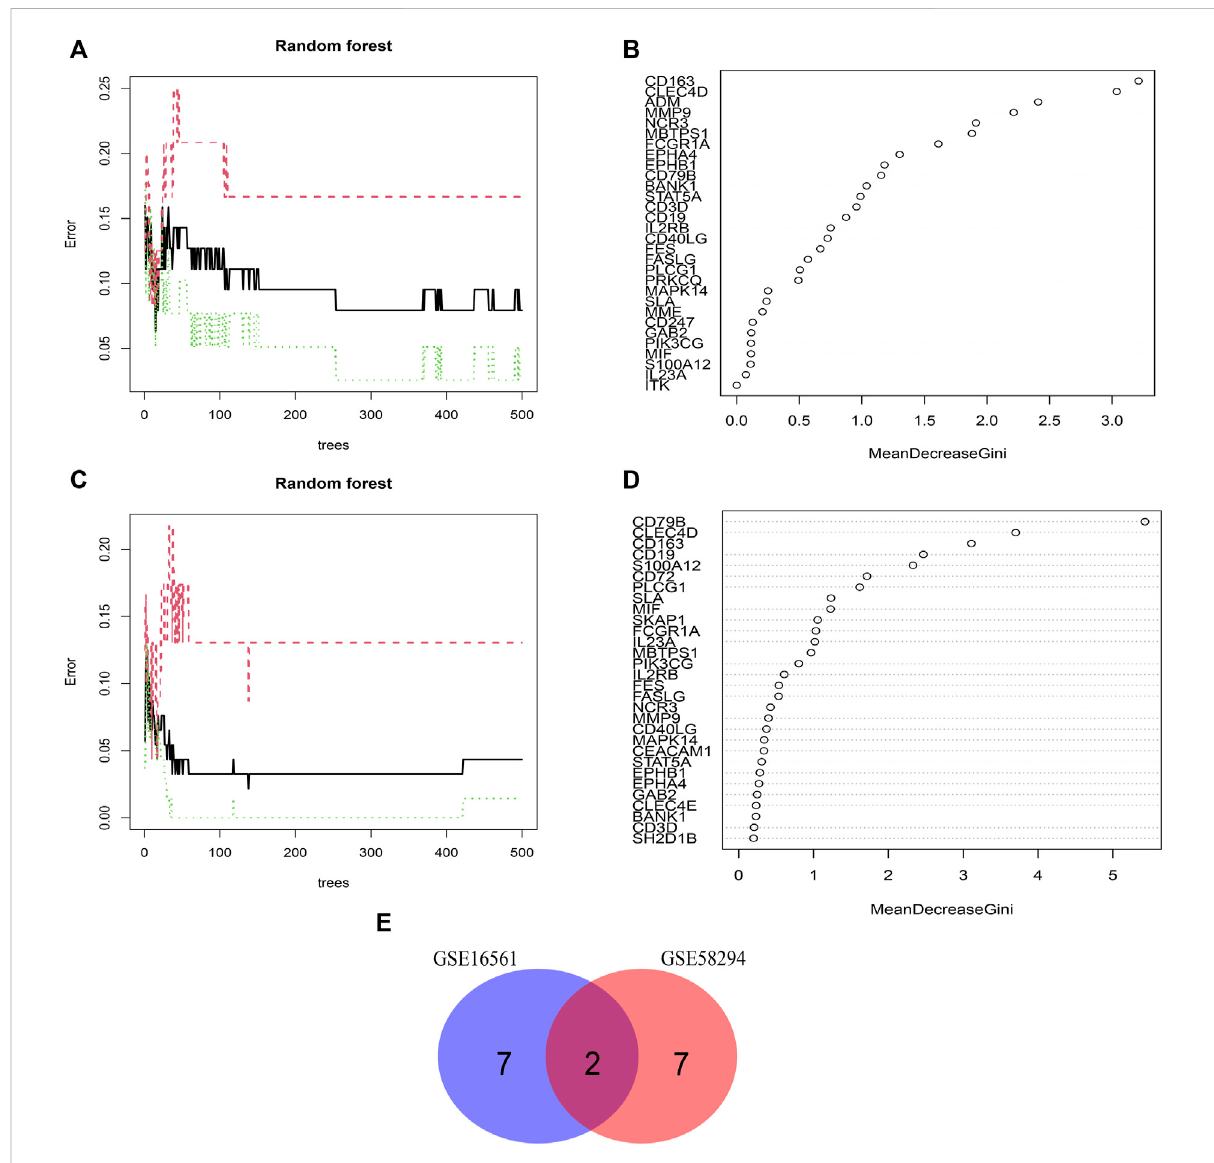
FIGURE 4 Screening of Key Features of IS immune biomarkers. (A,B) Random Forest model screening for key features in the GSE16561 dataset. (C,D) Random Forest model screening for key features in the GSE58294 dataset. (E) Venn diagram showing the intersection of key features between the GSE16561 and GSE58294